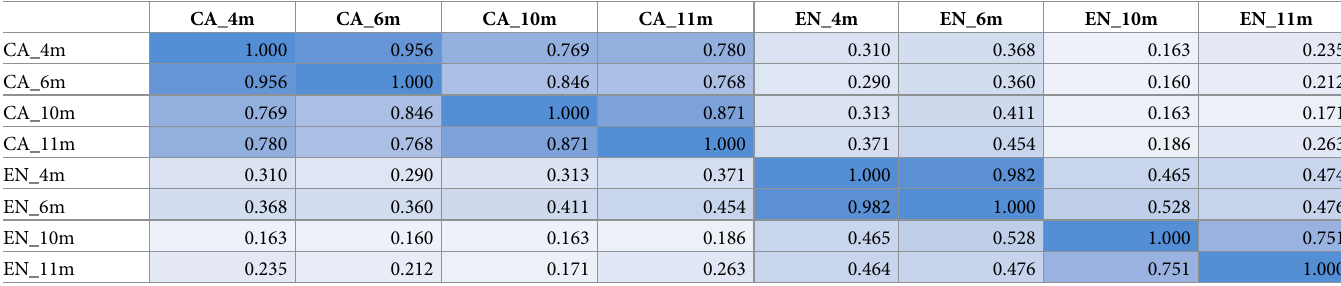
Table 1. Correlation of tissues by gestational age.